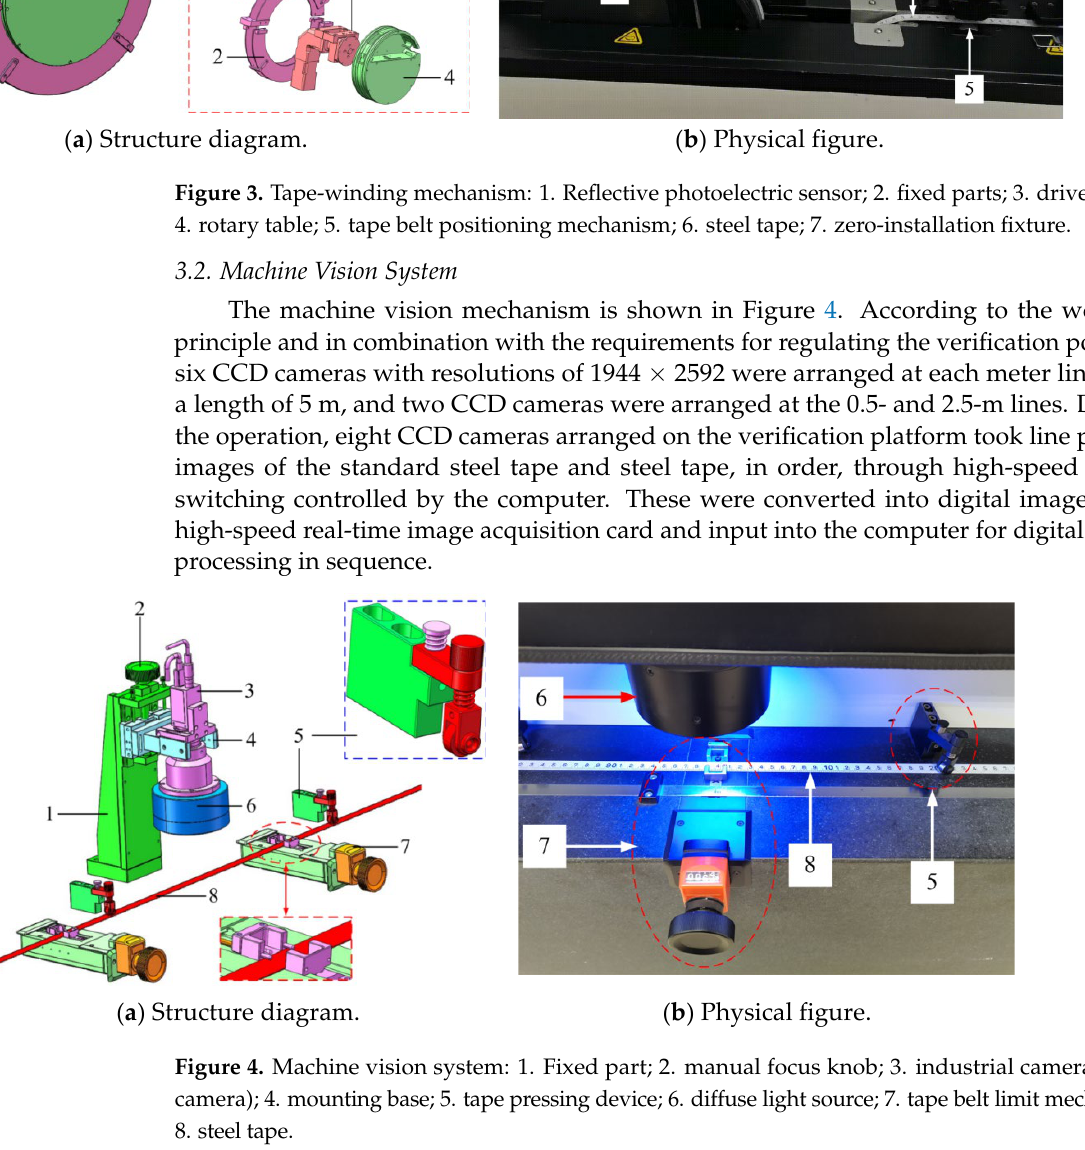
Figure 4. Machine vision system: 1. Fixed part; 2. manual focus knob; 3. industrial camera (CCD camera); 4. mounting base; 5. tape pressing device; 6. diffuse light source; 7. tape belt limit mecha- nism; 8. steel tape.